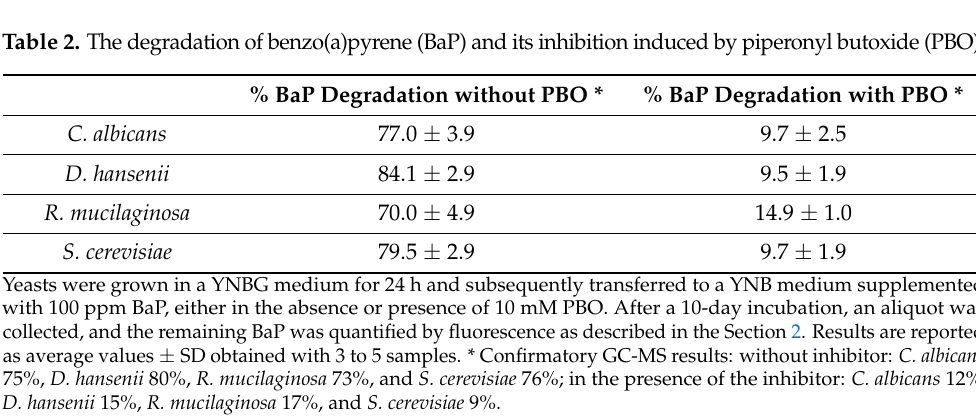
Table 2. The degradation of benzo(a)pyrene (BaP) and its inhibition induced by piperonyl butoxide (PBO).